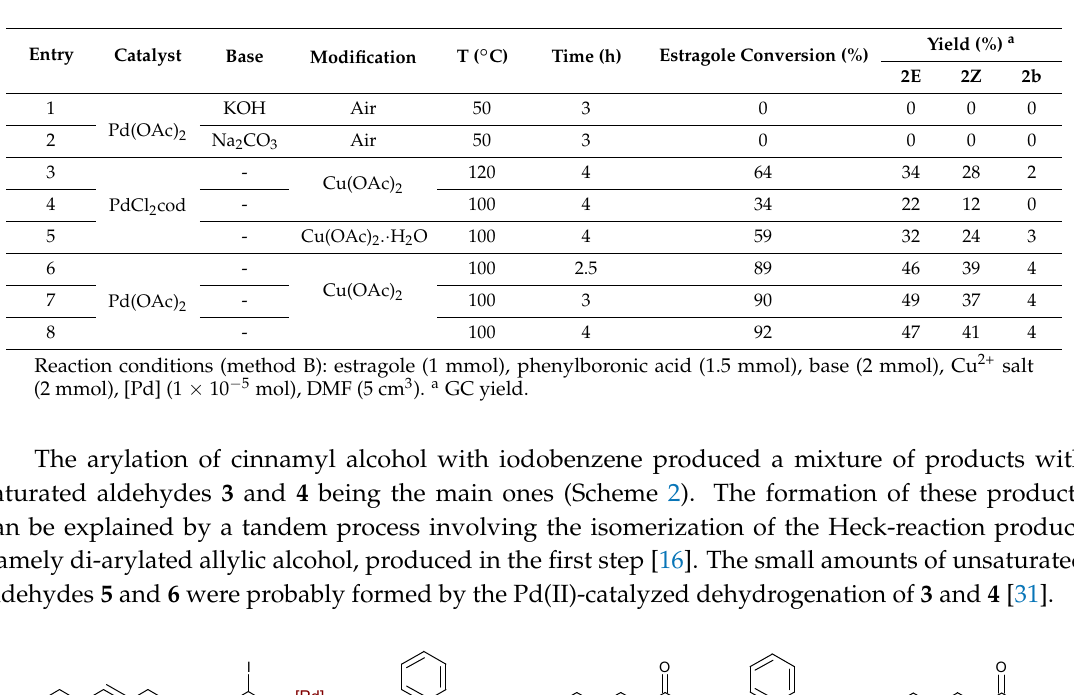
Table 4. Results of the Heck-type reaction of estragole with phenylboronic